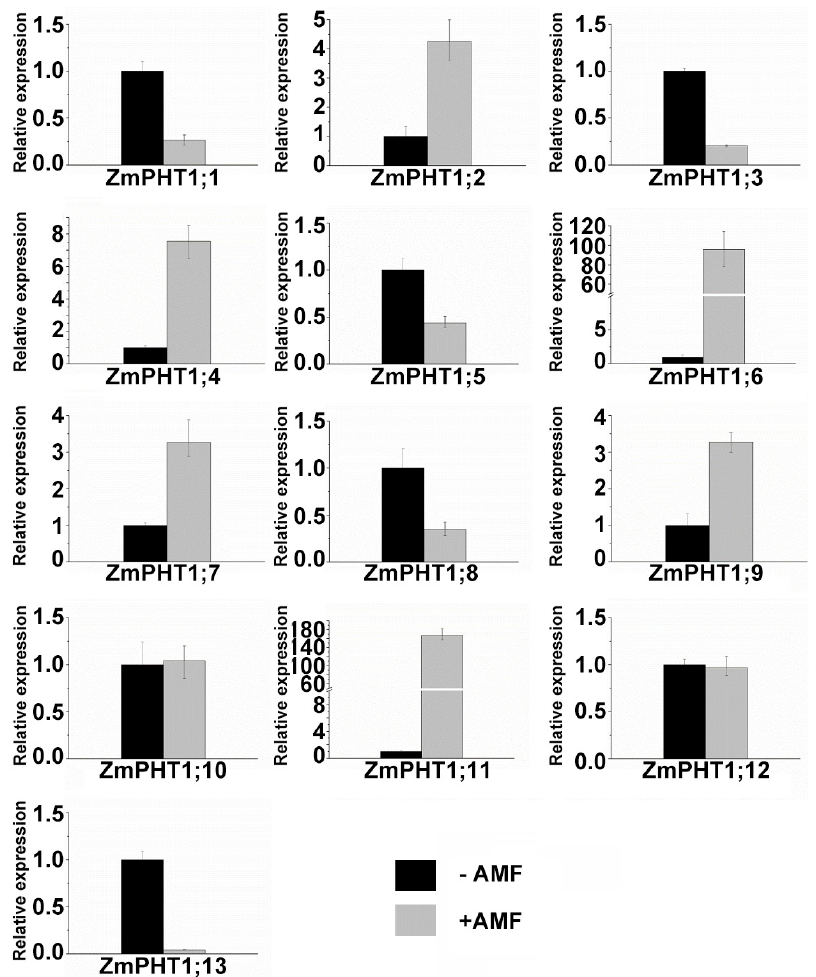
Figure 7. qRT-PCR analysis of ZmPHT1 genes in root samples in response to AMF inoculation under low Pi supply. Maize were grown in a low Pi (50 µM) condition and an inoculation with autoclaved and active Glomus etunicatum , respectively. Data points are the means ± SD ( n = 3 biological replicates of three plants each).